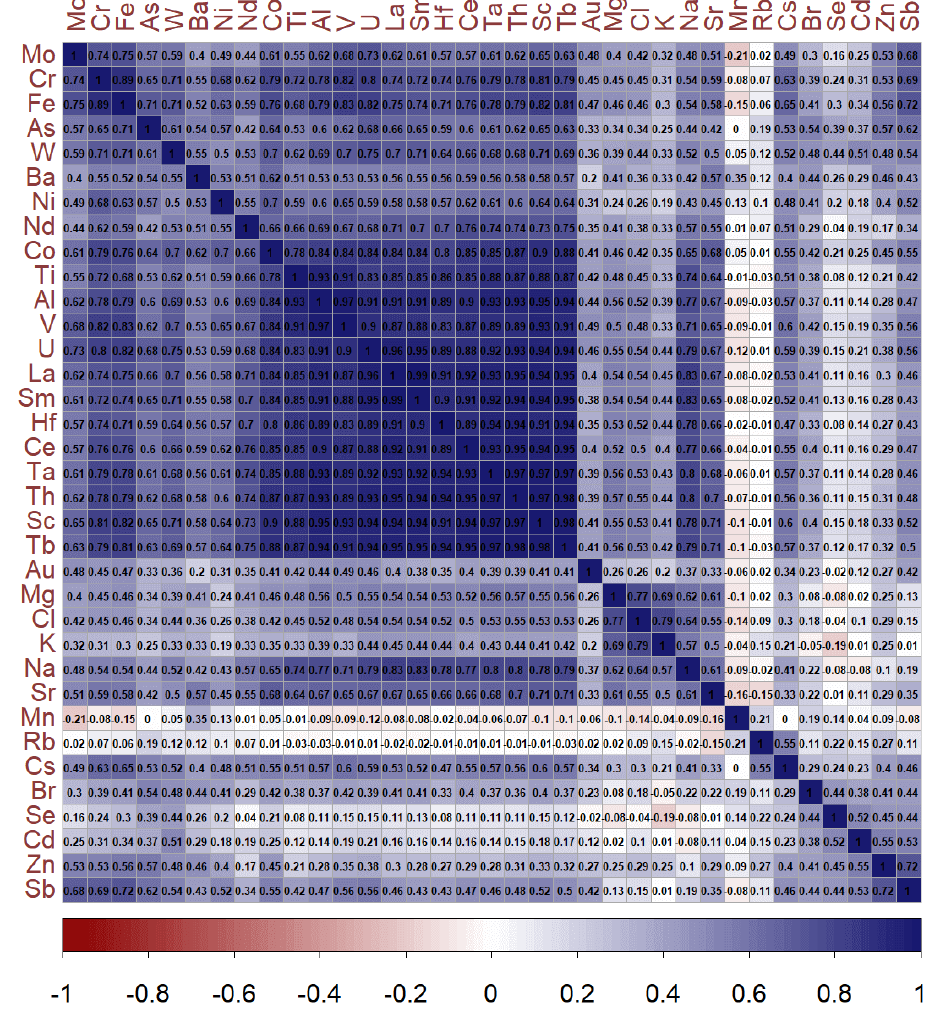
Figure 4. Correlation matrix of the chemical element concentrations in mosses analyzed using